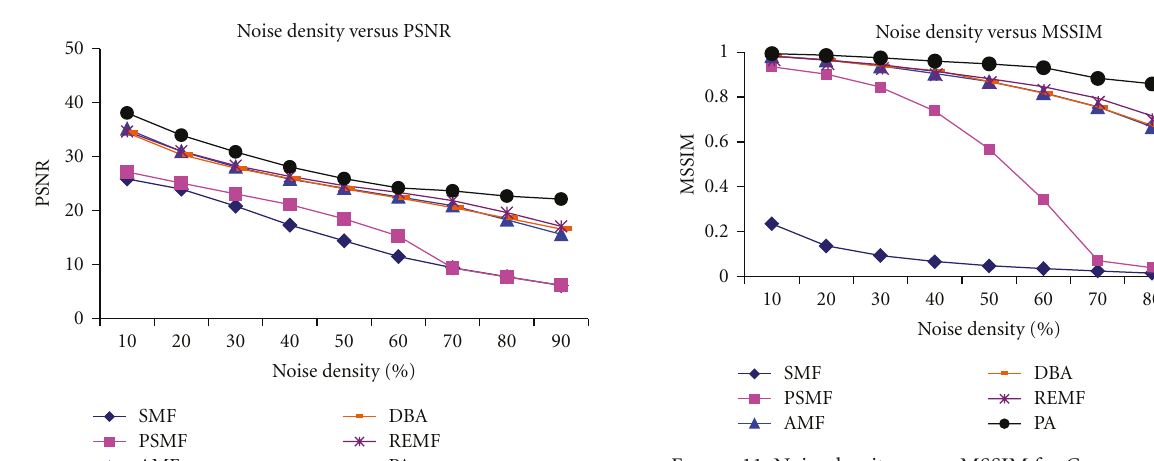
Figure 11: Noise density versus MSSIM for Cameraman image.